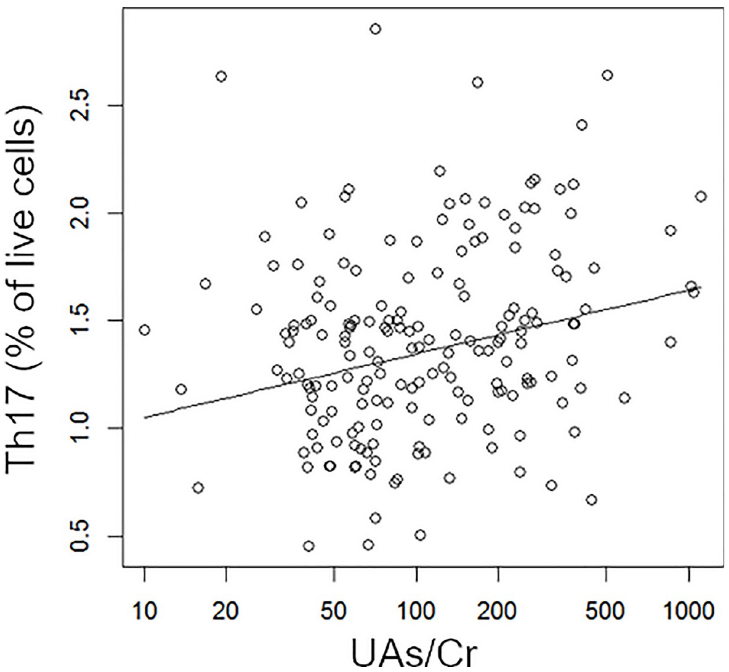
Fig 3. Covariate-adjusted association between UAs/Cr and Th17 cells. Individual data points represent observations; solid line represent estimated mean outcome Th17 1/3 vs. UAs/Cr adjusted for other variables in the